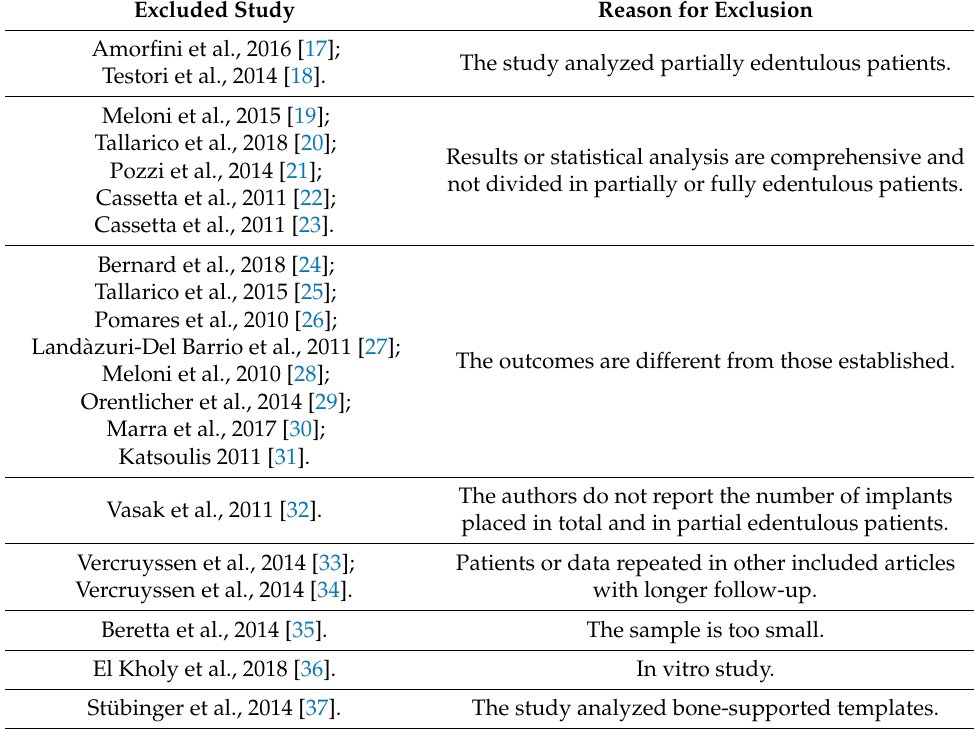
Table 1. Excluded studies and reason for